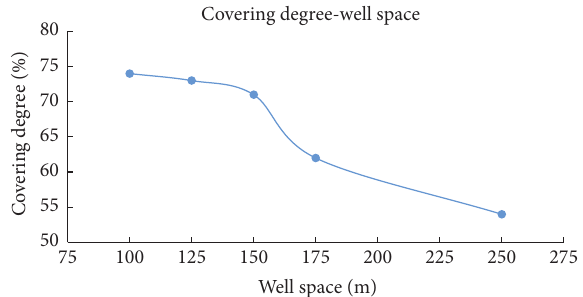
Figure 8: Relationship between injection production well space and covering degree [13–15].